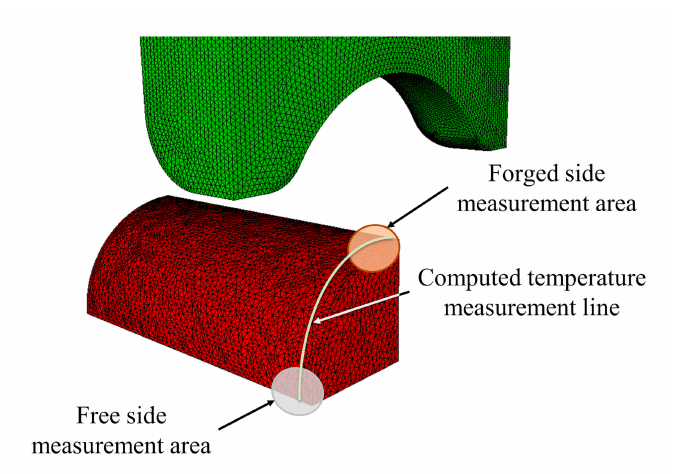
Figure 6. Areas of temperature measurements on the representative test.